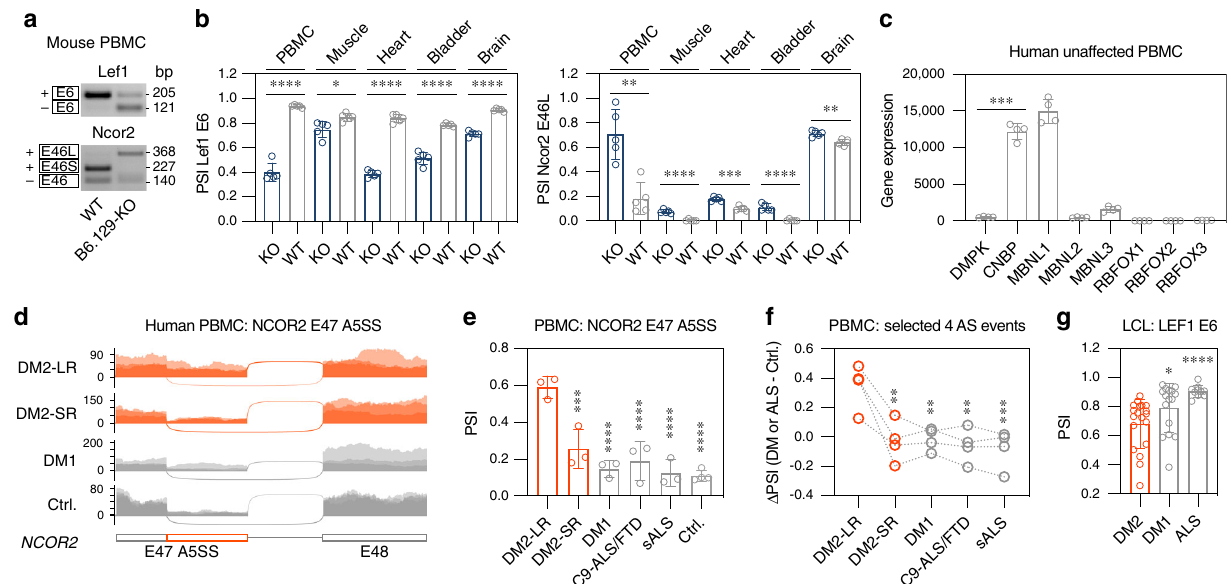
Fig. 4 Alternative splicing changes in Mbnl1 KO and DM2 PBMCs. a Representative RT-PCR assay gel of Lef1 E6 and Ncor2 E46 A5SS from 129.B6- Mbnl1 KO and WT PBMCs. b 129.B6- Mbnl1 KO ( n = 5) causes Lef1 E6 exclusion and Ncor2 E46L inclusion in peripheral blood mononuclear cells (PBMCs), muscle (tibialis anterior), heart, bladder and brain. Bar graphs show mean PSI ± SD. Signi fi cant difference was determined by the two-tailed t -test test: * P < 0.05, ** P < 0.01, *** P < 0.001, **** P < 0.0001. c Gene expression in unaffected human PBMCs. Bar graph shows mean expression value ± SD. Signi fi cant difference was determined by two-tailed t-test test: *** P = 0.0003. d Sashimi plot of DM2-LR (>1000 CCTGs; n = 3), DM2-SR (~100 CCTGs; n = 3), DM1 ( n = 3) and unaffected control ( n = 4; PBMC extraction delayed by 24 – 48 h) RNA-seq samples for NCOR2 E47-E48. e Aberrant NCOR2 E47L inclusion in DM2-LR but not in DM2-SR, DM1, C9-ALS/FTD nor sALS. Bar graph shows mean PSI ± SD. Signi fi cant difference was determined by Dunnett ’ s multiple comparison test: *** P adj = 0.0004, **** P < 0.0001. f Before-after plot shows individual Δ PSI values for NCOR2 E47, MBNL1 E5, SYNE1 E61 and GIT2 E16 AS events. Note that Δ PSI values for GIT2 E16 are inverted. Signi fi cant difference was determined by Dunnett ’ s multiple comparisons test: ** P adj < 0.01, ** P adj = 0.0009. g Aberrant LEF1 E6 exclusion in a large cohort of DM2-derived LCLs ( n = 19); DM1 ( n = 16); ALS ( n = 10). Signi fi cant difference was determined by Dunn ’ s multiple comparison test: * P adj = 0.019, **** P adj < 0.0001. Source data are provided as the Supplementary Data 1 and Source Data fi